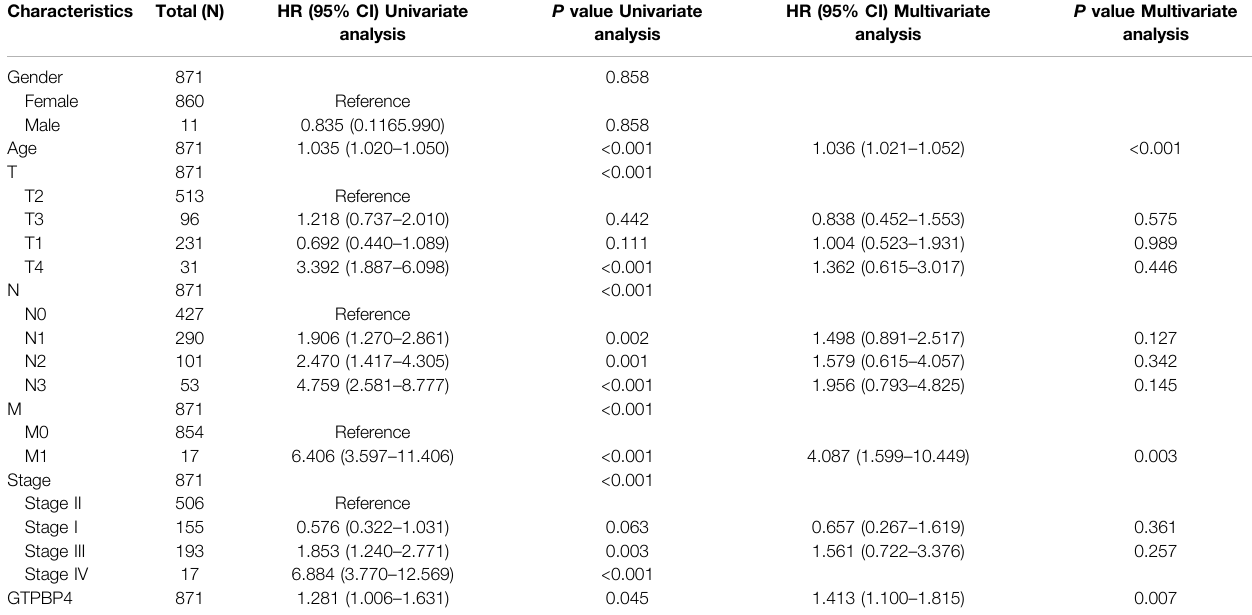
patients. Patient “ TCGA-AR-A255 ” had 1-, 3-, and 5-year death rates of 0.0113, 0.0617, and 0.112, respectively, as shown in Figure 8A . The AUC values of the 3-year and 5-year ROC curves for this nomogram were 0.77 and 0.75, respectively ( Figure8B , 8c ). The nomogram can accurately predict the survival of breast cancer patients, according to the 3-year and 5-year calibration curves ( Figures 8D,E ).